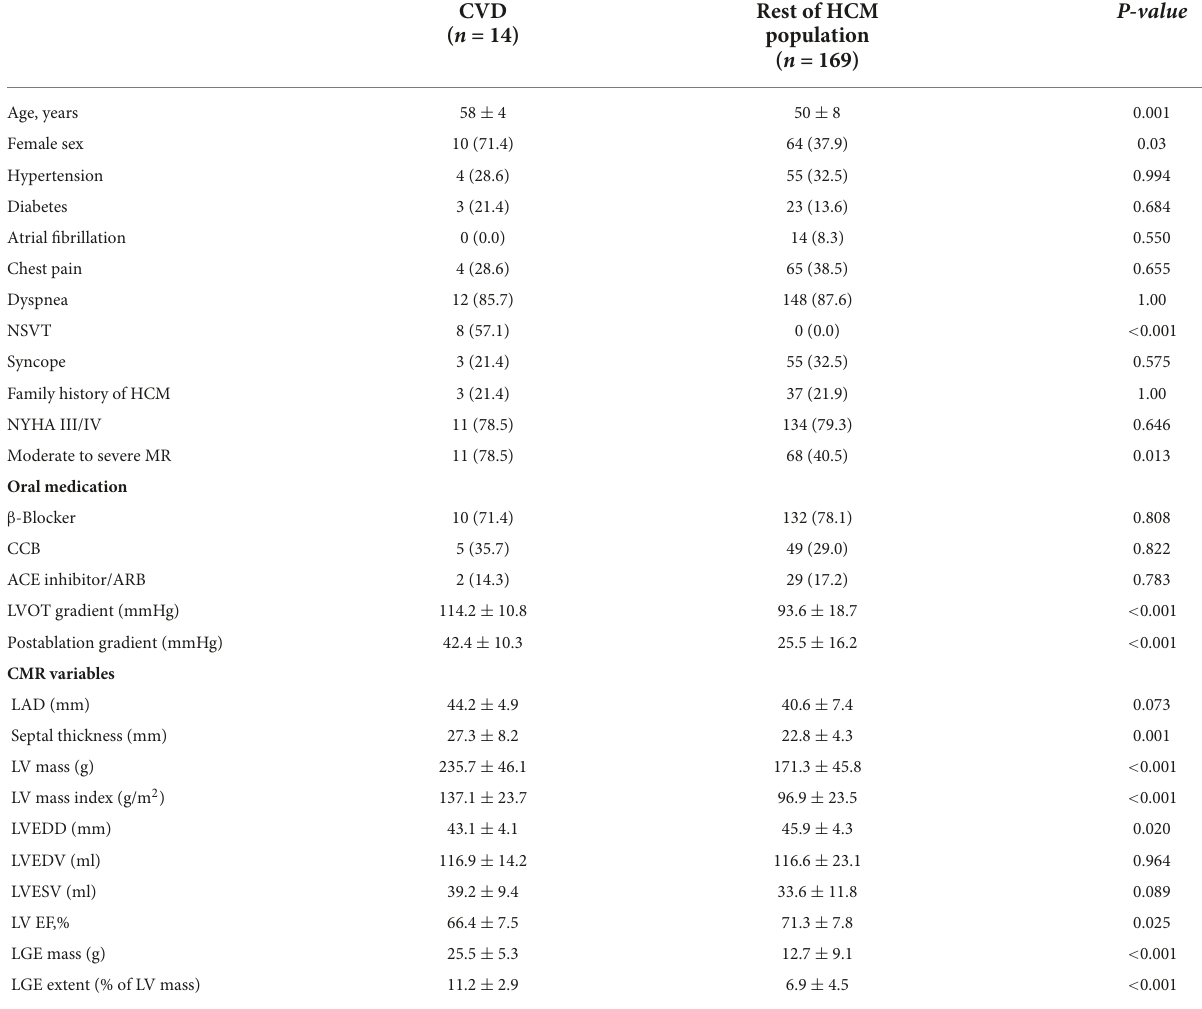
TABLE 2 Comparison of clinical and CMR characteristics of patients with cardiovascular-related mortality with the remainder of the cohort after ASA.